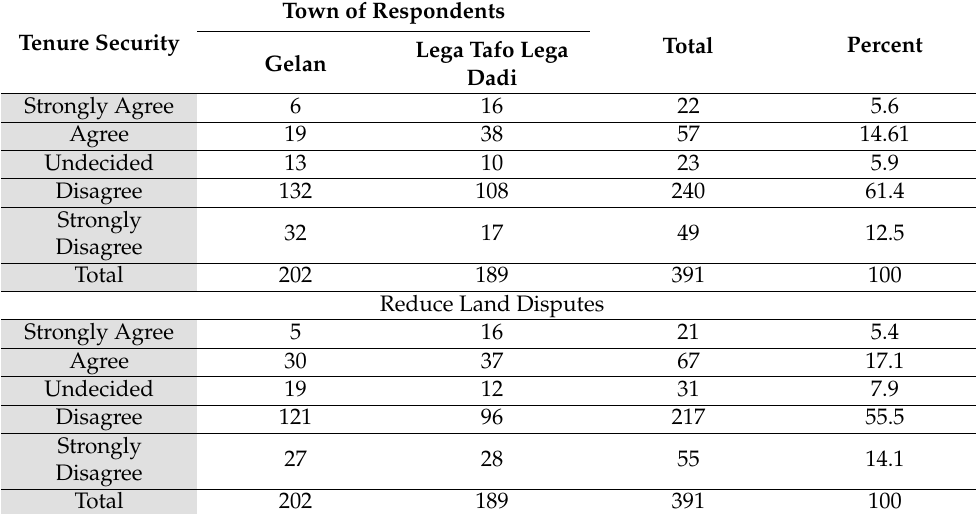
Table 2. The response rate of respondents on tenure security and land